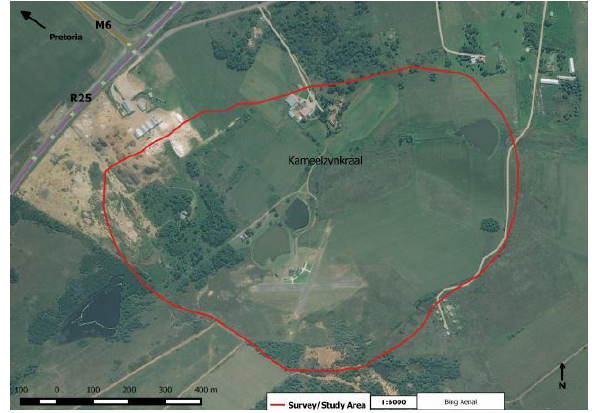
Figure 1. The Cors-Air study area to the east of Pretoria, Gauteng Province.